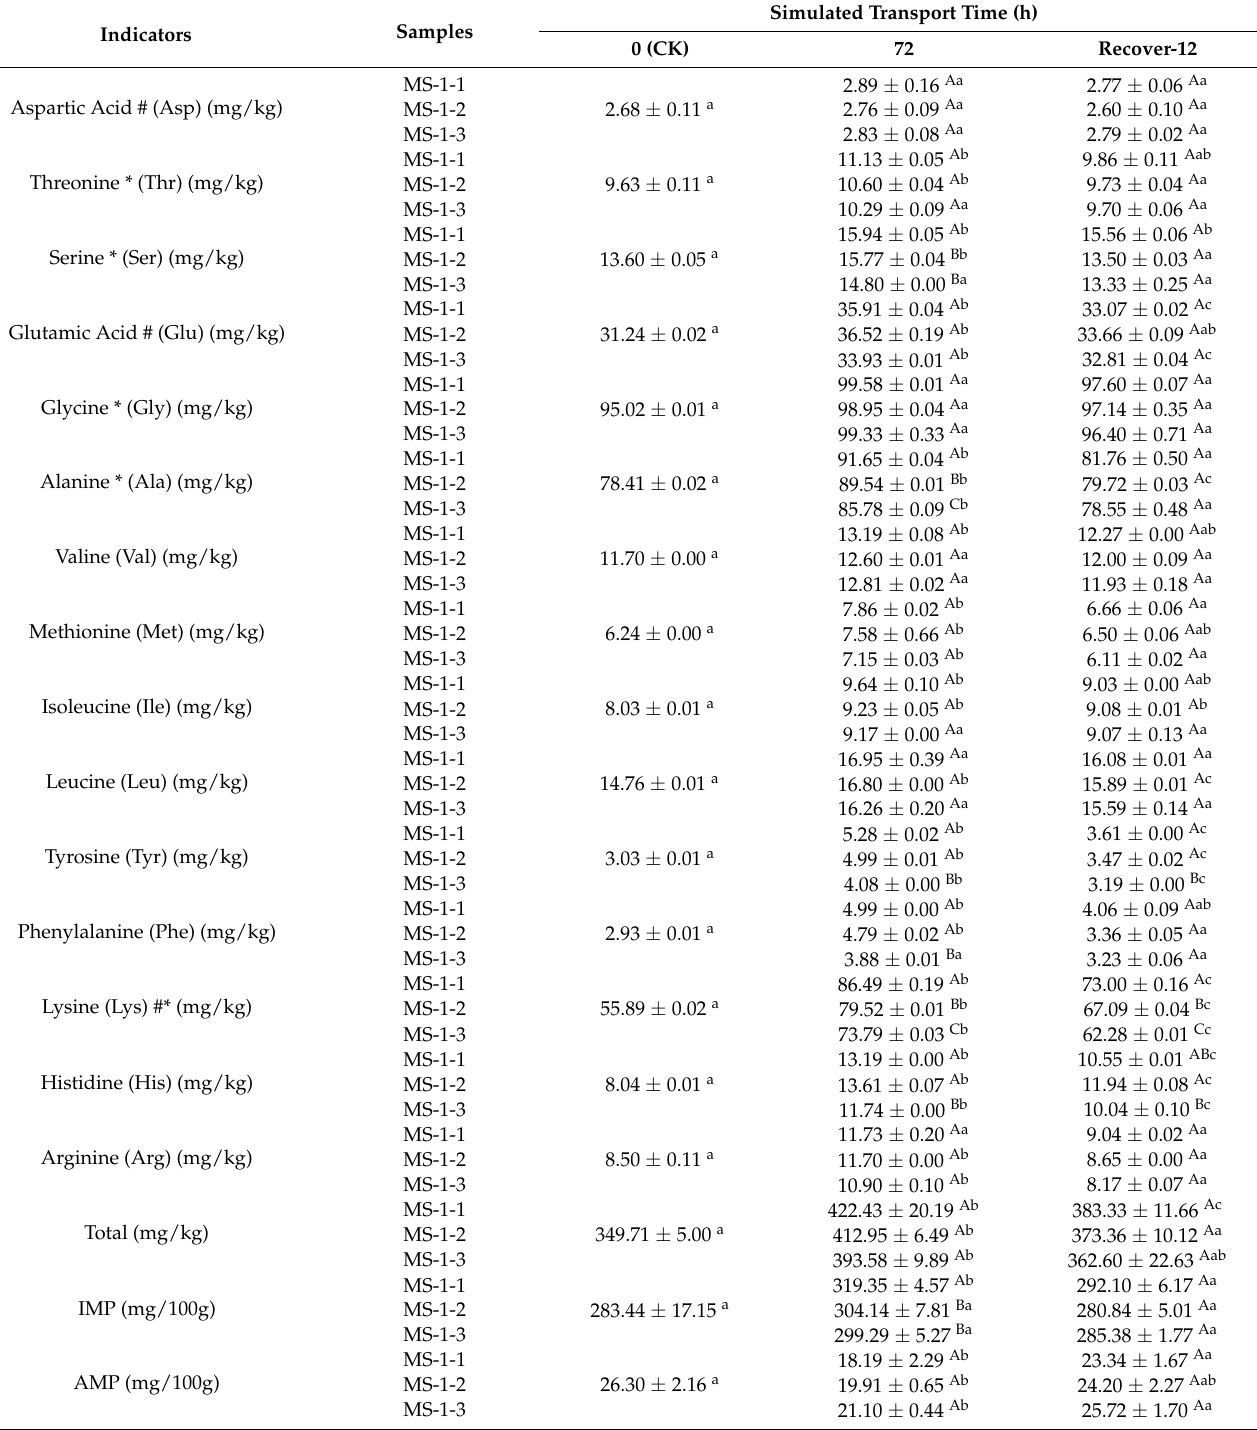
Table 4. The changes in free amino acid and nucleotide of the sea bass before and after simulated live